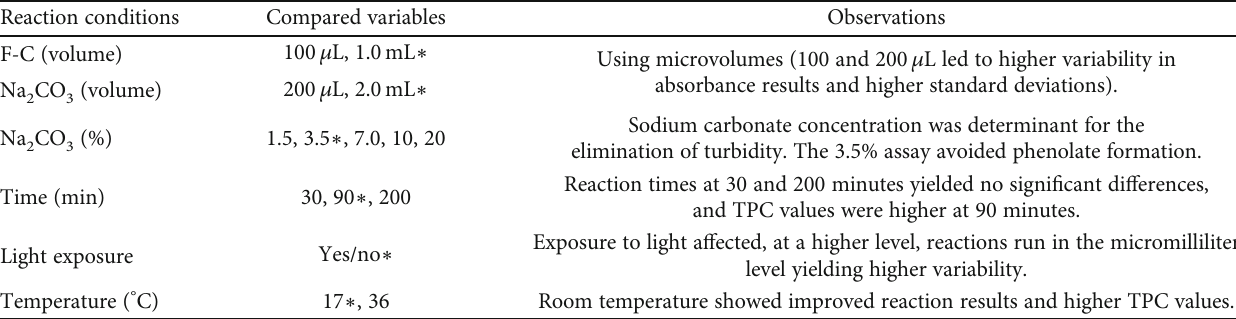
Table 2: Alternative F-C reacting conditions for TPC in Passi fl oras ( ∗ conditions representing signi fi cant di ff erences and the best treatment based on ANOVA and post hoc Tukey ’ s HSD test considering p < 0 : 05 ).